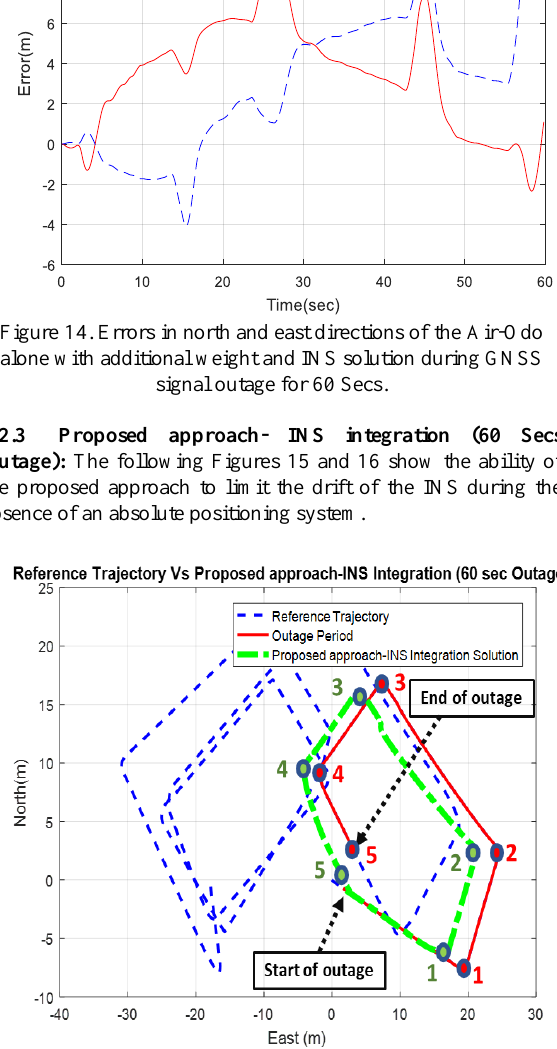
Figure 15. Solution of the proposed approach integrated with INS during 60 Secs of GNSS signal outage.